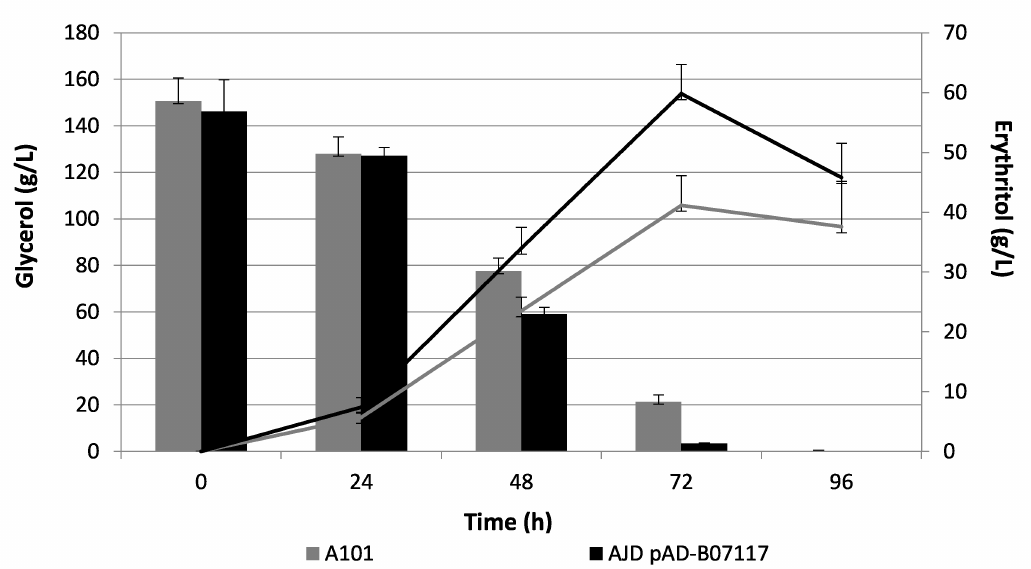
Figure 5. Erythritol synthesis (line chart) and glycerol utilization (bar chart) in batch reactors in an erythritol synthesis medium for the A101 strain (gray) and the AJD pAD-B07117 strain (black).